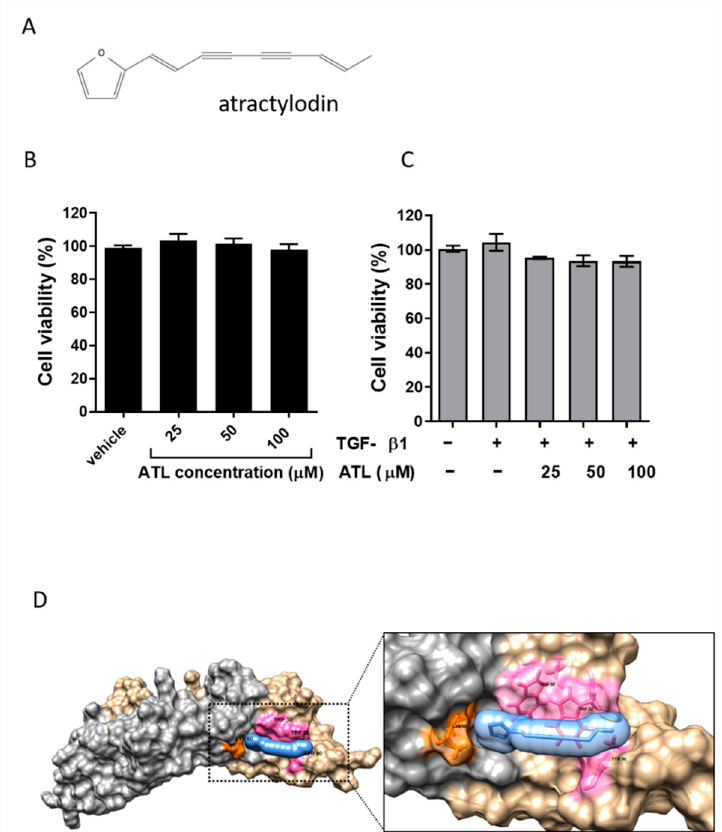
Figure 1. Atractylodin caused neglectable cytotoxicity on A549 cells with or without TGF- β 1. ( A ) The molecular structure of atractylodin. ( B ) The cell viability of A549 cells treated with ATL (0, 25, 50, 100 μ M) for 24 h was determined by MTT assay. ( C ) The cell viability of A549 cells treated with different concentrations of ATL in the presence of TGF β 1 (2 ng/mL) was measured by MTT assay. Values represent the mean ± SEM from triplicate samples for each treatment. ( D ) 3D structure of the docking model. Atractylodin is indicated in blue; the homodimer is composed of TGF- β 1A (in tan) and TGF- β 1B (in grey); amino acid residuals interacting with TGF- β 1 receptor are labeled in pink for Trp30, Trp32, Tyr90 of TGF1- β 1A and in orange for Lys60 of TGF- β 1B. Values represent the mean ± SEM from triplicate samples for each treatment.